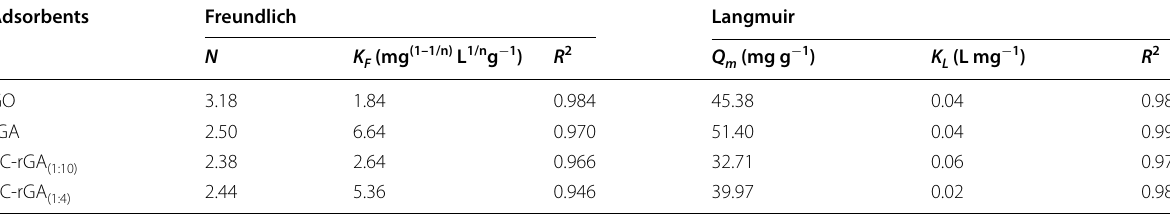
Table 2 Adsorption isotherm parameters of Cr(VI) adsorption on GO and aerogels